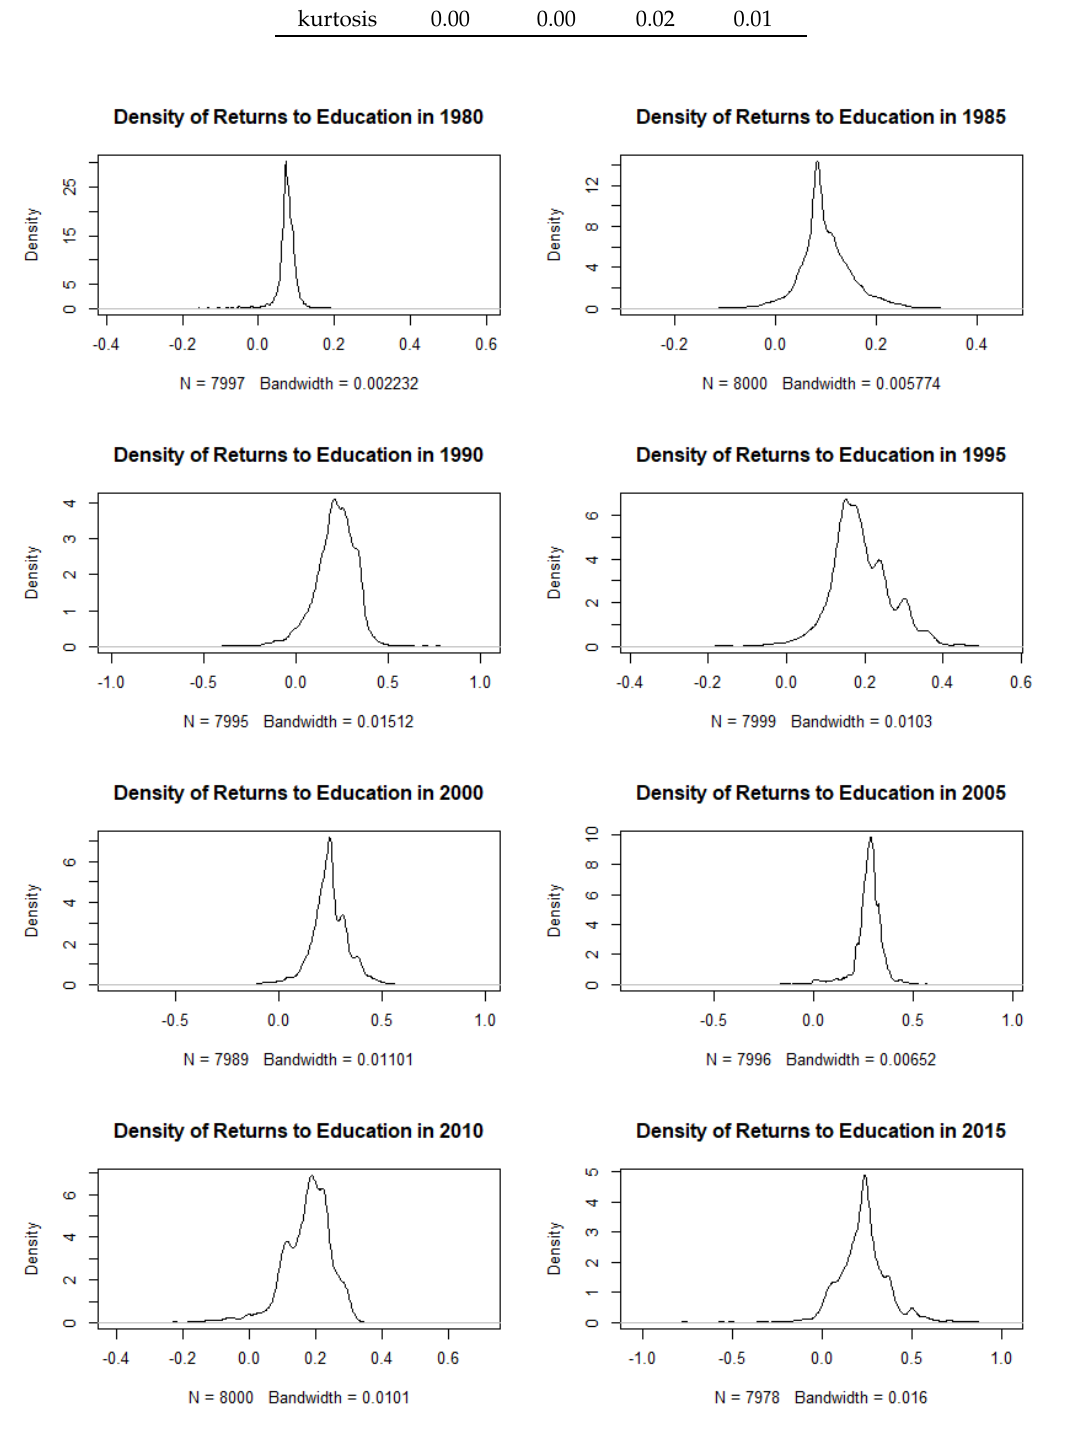
Figure 2. Densities of gradients on schooling (education) from Step